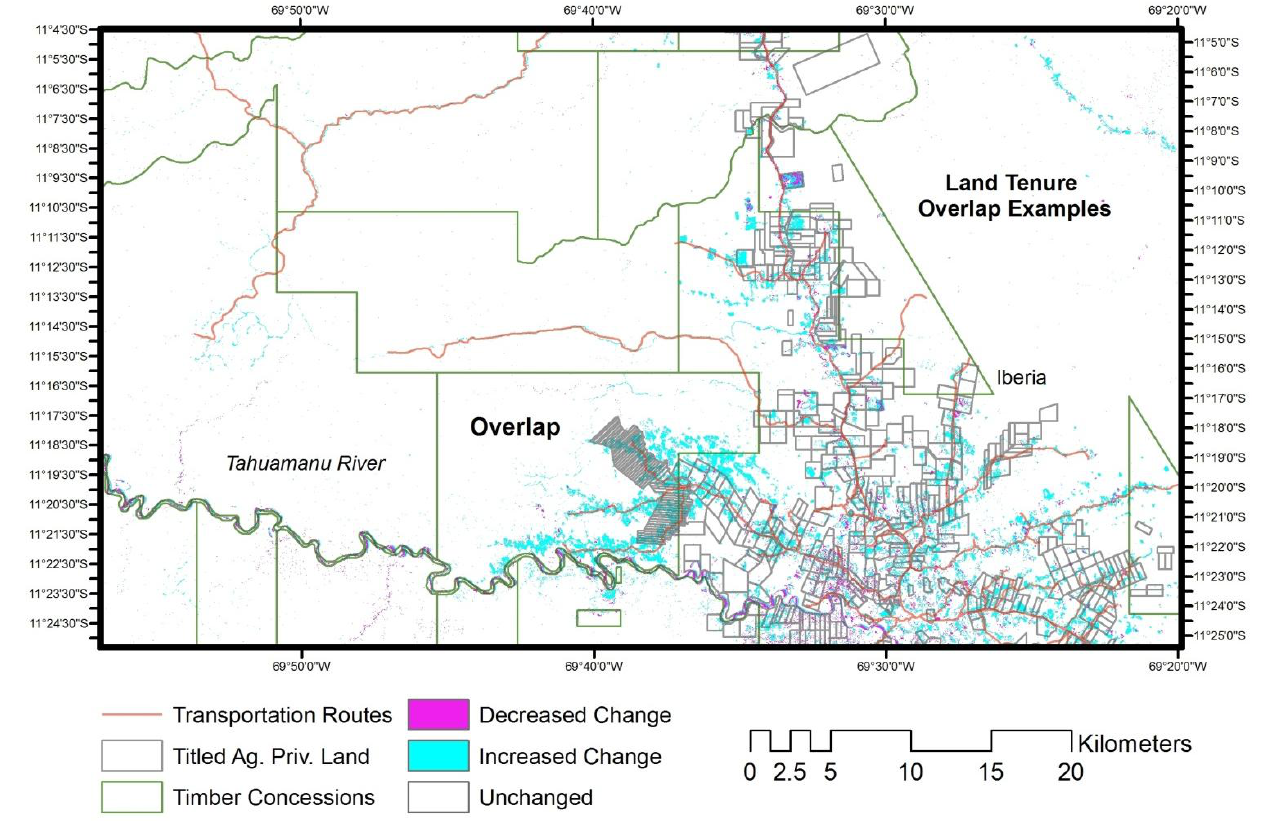
Figure 9. Overlap of agricultural areas and timber concession close to the town of Iberia and the Tahuamanu